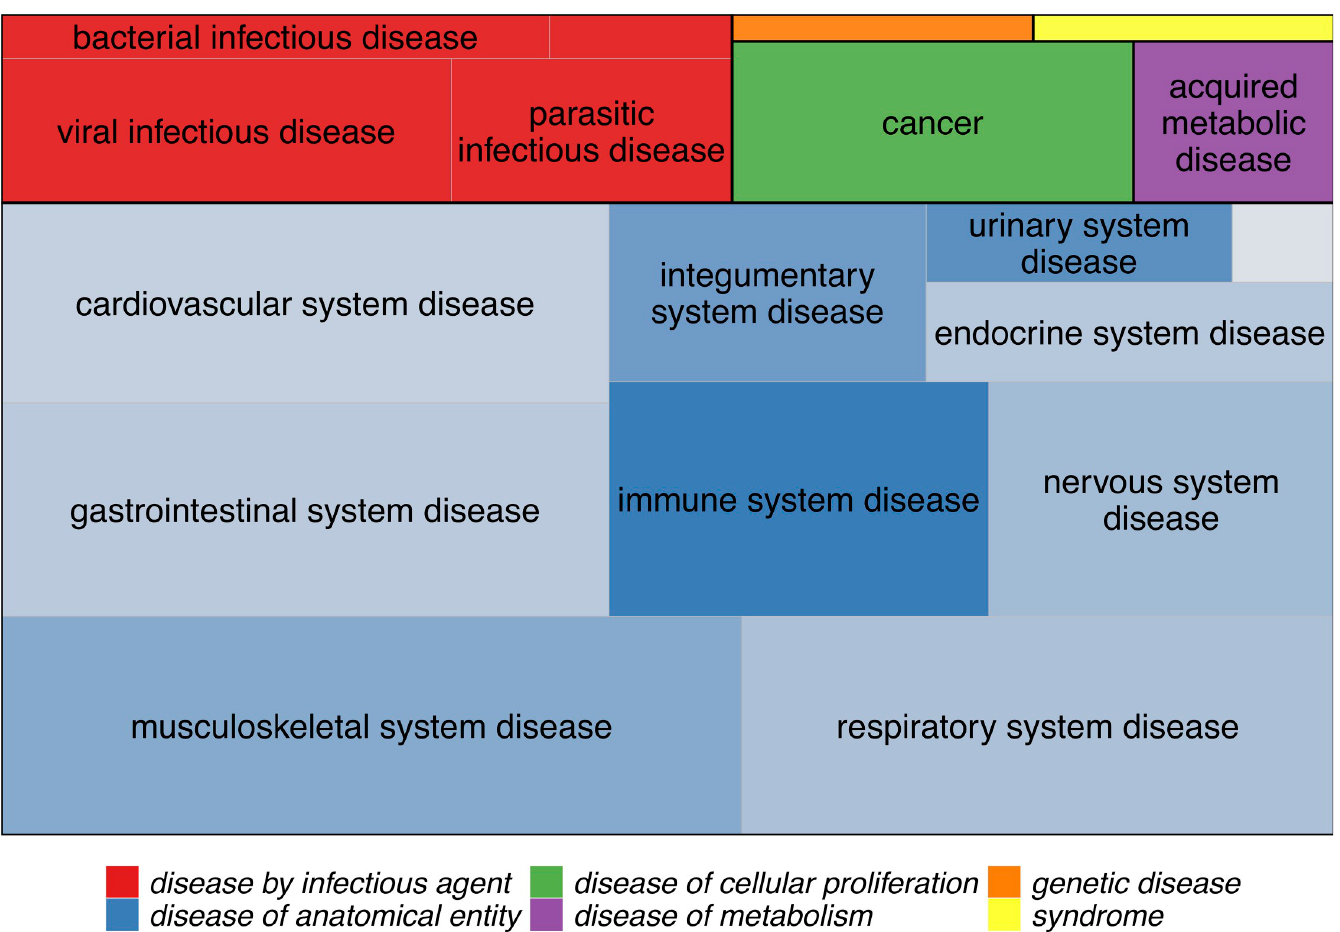
Fig 3. Disease Ontology categories for the 136 diseases that showed overrepresentation of green module genes. Boxes are colored according to the top-level disease categories and labels show the second-level categories. The size of each box is proportional to the number of disease terms in that category with significant overrepresentation of green module genes. Some disease terms belong to more than one category (e.g., multiple sclerosis is both a “nervous system disease” and an “immune system disease”), but each term is only represented once. For “disease of anatomical entity” terms, squares are shaded by the proportion of terms that represent autoimmune/inflammatory diseases (e.g., 3 of 16 “gastrointestinal system disease”terms are autoimmune/inflammatory, while 9 of 11 “immune system disease” terms are). The full list of disease terms, with (manually curated) autoimmune/inflammatory terms highlighted, is given in S3 File.